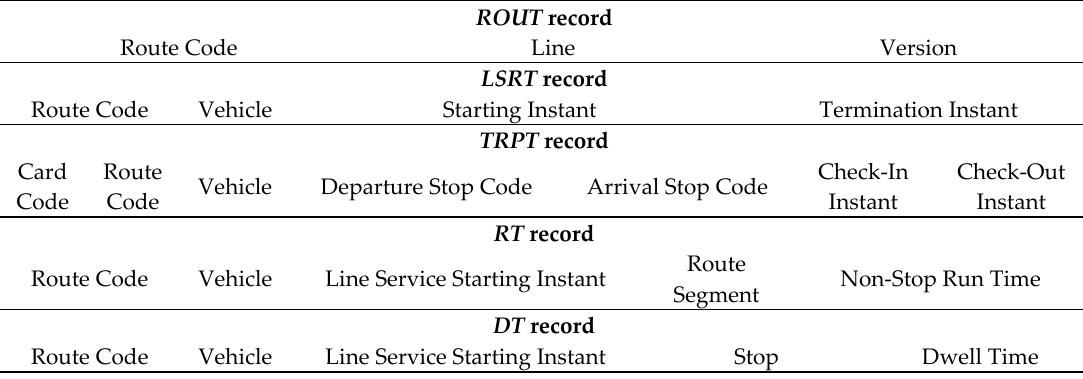
Table 2. Structure of the registers of the dynamic tables of the